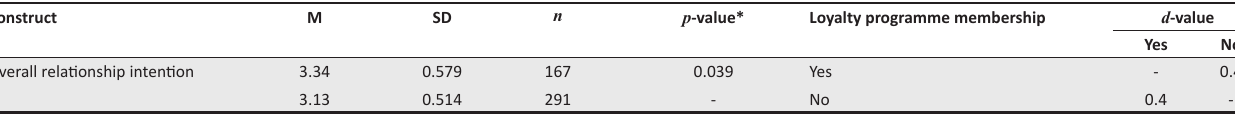
TABLE 4: Overall relationship intention and loyalty programme membership. Construct M